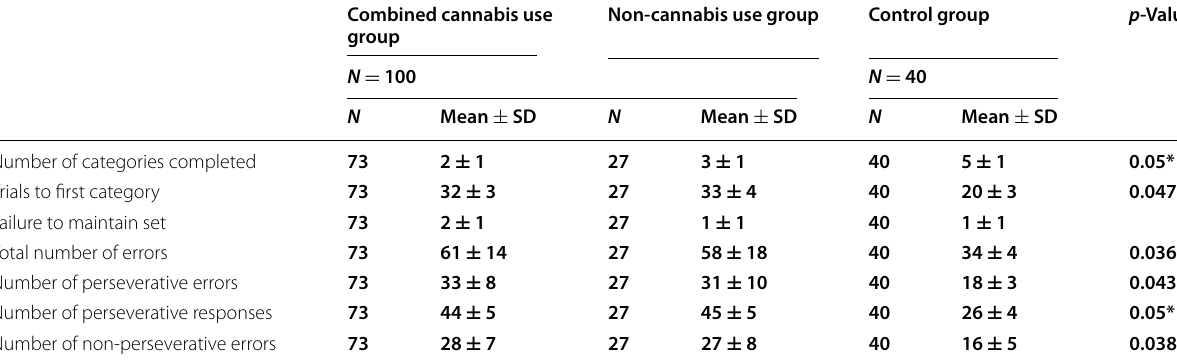
* p -value < 0.05 significance. Shows that combined cannabis use group had lower mean than non-cannabis use group, control group as regard all domains except failure to maintain set, and the difference had statistically critical ( p 0.05) which means that cannabis use might affect the executive function domains except = sustained attention